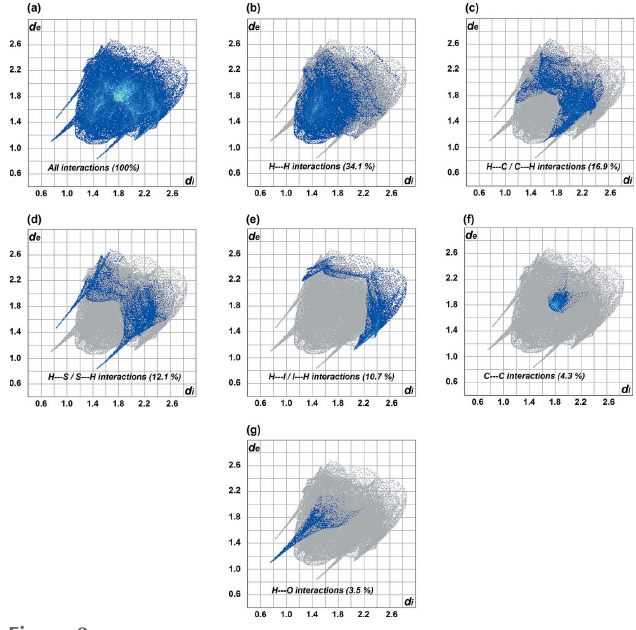
Figure 8 The fingerprint plots for ( 2